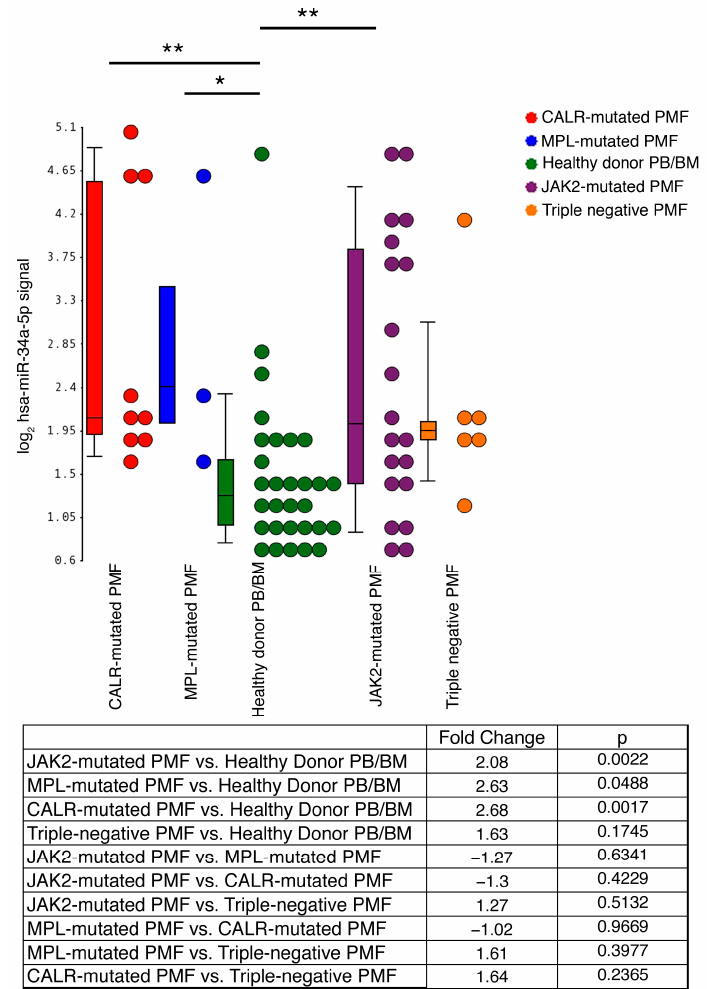
Figure 1. Expression levels of miR-34a-5p in CD34+ cells from primary myelofibrosis (PMF) patients and healthy donors (HDs). Gene expression levels were measured by microarray analysis performed by Affymetrix platform as detailed in Materials and Methods Section 4.2. miR-34a-5p expression levels are reported as Robust Multiarray Analysis (RMA)-normalized log2 signals, which were obtained by using the Partek ® Genomics Suite ® software, version 6.6 Copyright © , 2016 (Partek Inc., St. Louis, MO, USA; http://www.partek.com). Boxes represent the interquartile range that contains 50% of the subjects, the horizontal line in the box marks the median, and bars show the range of values. Data are representative of 38 PMF and 30 HD samples (14 from bone marrow and 16 from peripheral blood). PMF samples are classified into JAK2 -mutated ( n = 20), MPL -mutated ( n = 3), CALR -mutated ( n = 9) and triple-negative ( n = 6), based on the mutational status. The table at the bottom of the figure displays the results (Fold Change and p -value) for the comparative analysis of JAK2 -mutated, MPL -mutated, CALR -mutated and triple negative PMF subgroups with the healthy donor-derived samples. Abbreviations: PMF, primary myelofibrosis; PB, peripheral blood, BM, bone marrow; n = number of samples. * p < 0.05; ** p < 0.01.